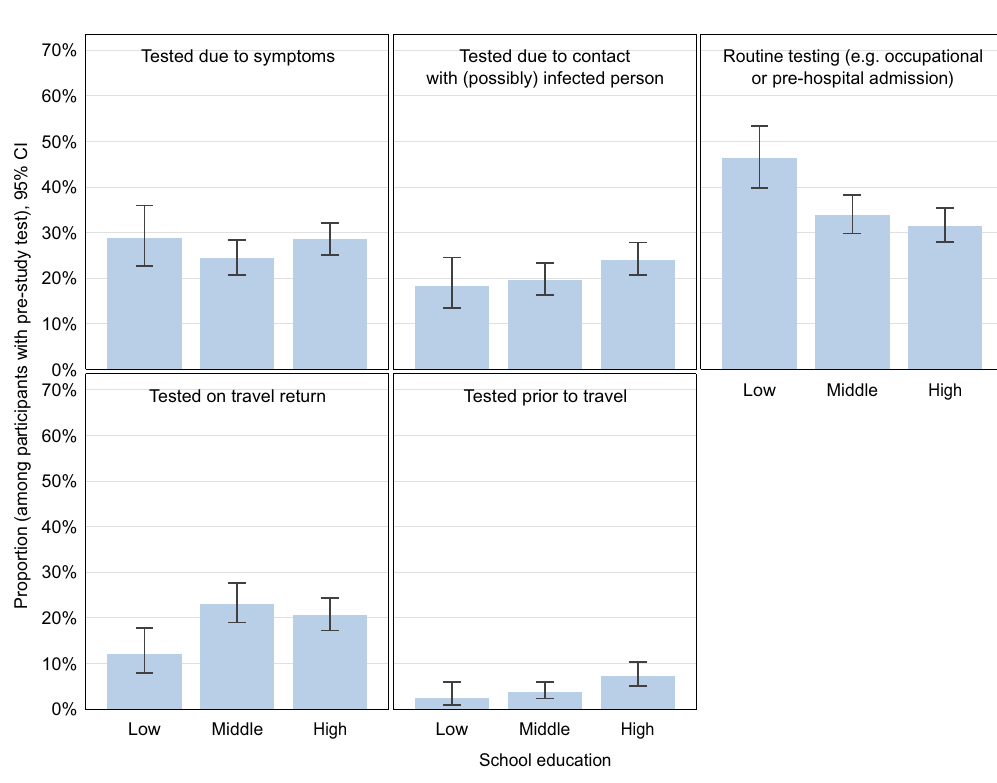
Figure 4. Self-reported reasons for pre-study tests (3502 RKI-SOEP study participants ever tested prior to study with complete data on reasons for testing, participation predominantly in October–November 2020), stratified by school education. Multiple answers were possible, “other reasons” not